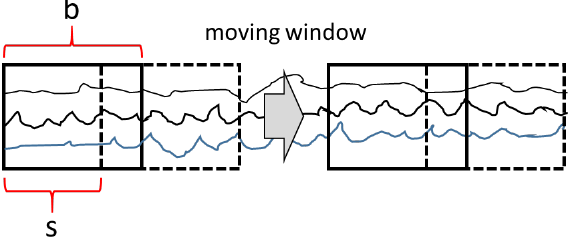
Figure 4. Time series segmentation using a sliding window algorithm.